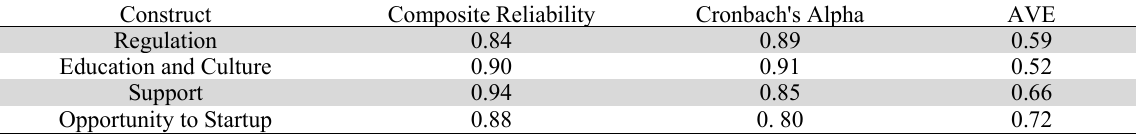
Questionnaire Validity and Reliability